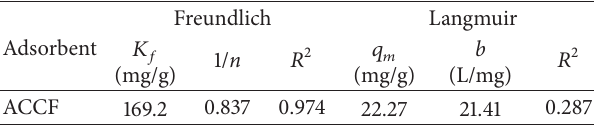
Figure 5: Effect of adsorbent dosage on the of Hg 2+ adsorption of ACCF. (Initial concentration 0.15mg/L, pH 4.08, and contact time 15 min). Table 1: Freundlich and Langmuir parameters for the Hg 2+ adsorp- tion of